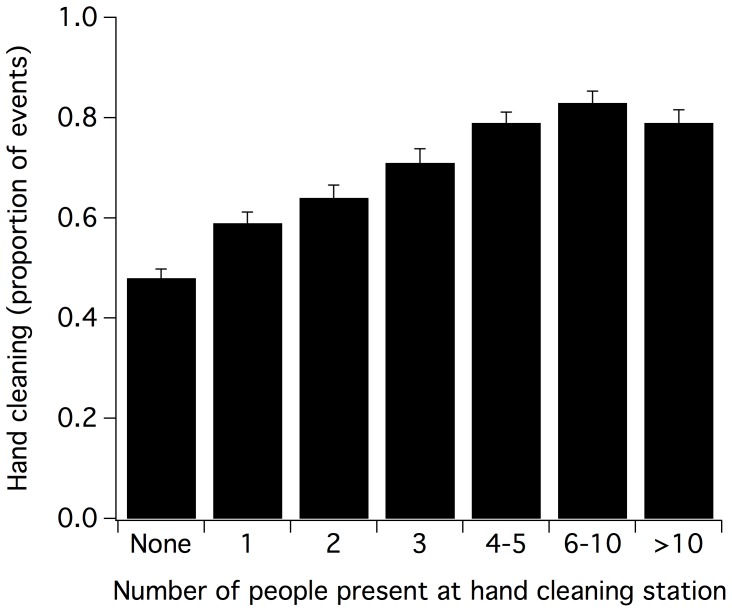
Proportion of student toileting events followed by hand cleaning, shown by number of other people present at the hand cleaning station (visible within the camera view frame).Error bars show standard error of the mean.